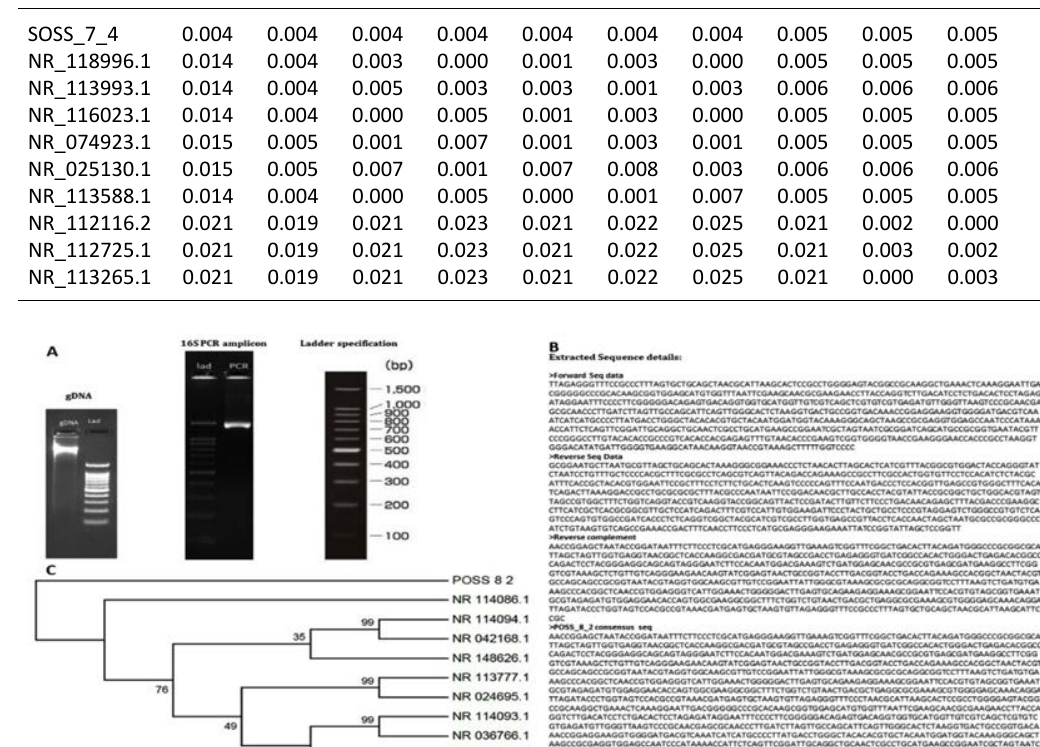
Table 4. Phylogenetic distance estimated using MEGA7 for the sample SOSS_7_4